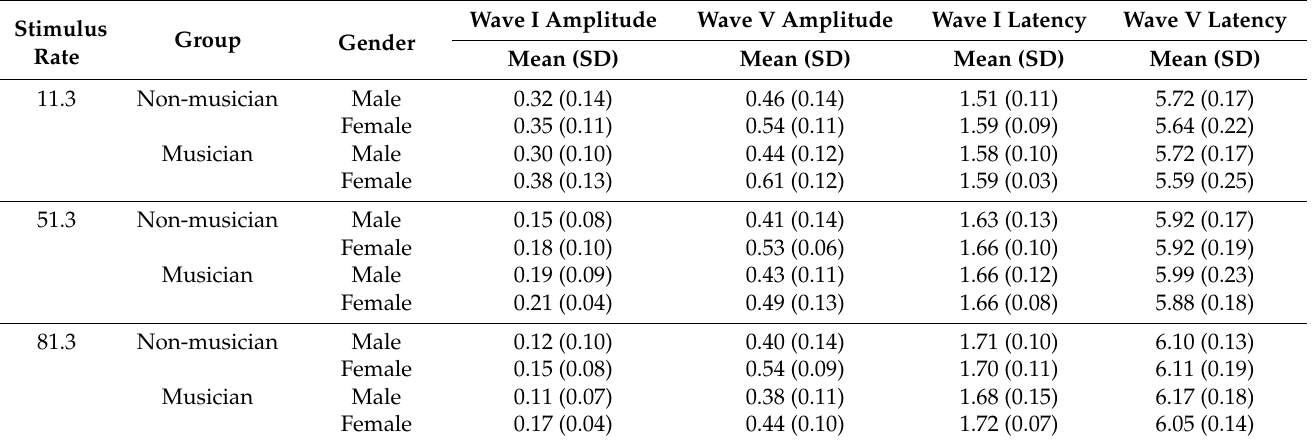
Table 2. The average amplitude and latency of waves I and V for each stimulus rate. The standard deviations are listed in parentheses.